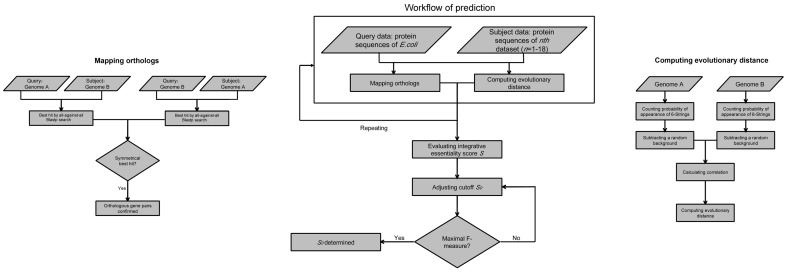
Training workflow based on 18 groups of essential genes and using Ecol as test.